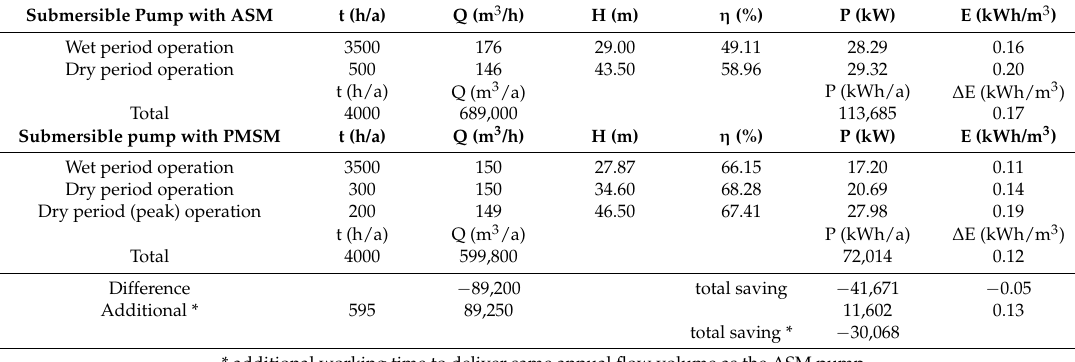
Table 2. Calculation of energy savings based on the measured operation